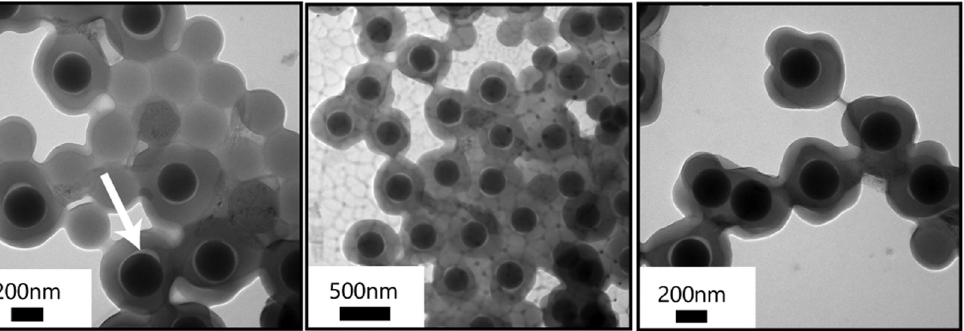
Figure 2: TEM images of the PClS/SiO 2 – MAPTMS core – shell particles. The polymer shell was cross - linked with DVB. The white arrow in the left panel indicates the gap between the core and the